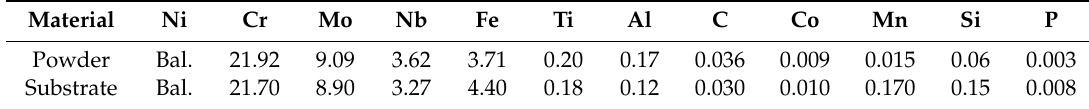
Table 1. The chemical compositions (wt %) of Inconel 625 alloy powder and substrate.